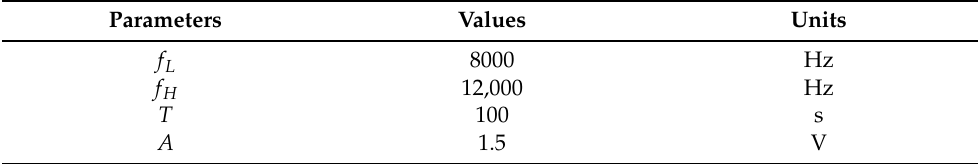
Table 2. Parameters of the chirp signal shown in Figure